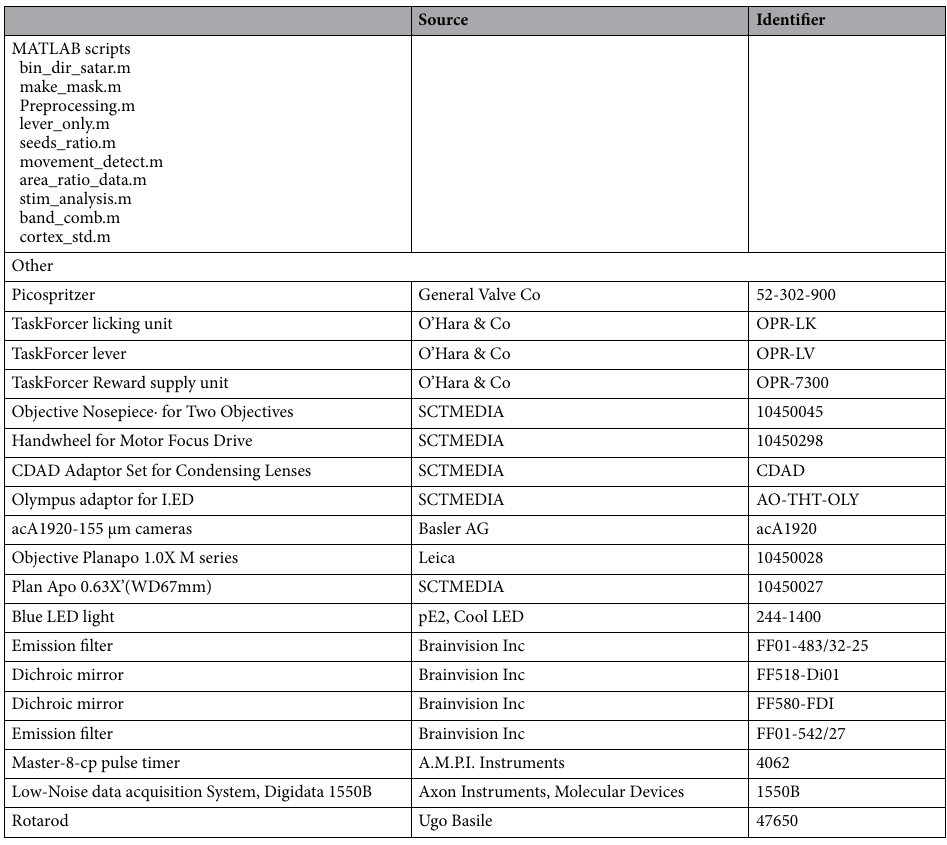
Table 1. Full list of reagents, equipment and suppliers. A comprehensive list of sources of all supplies, equipment and software